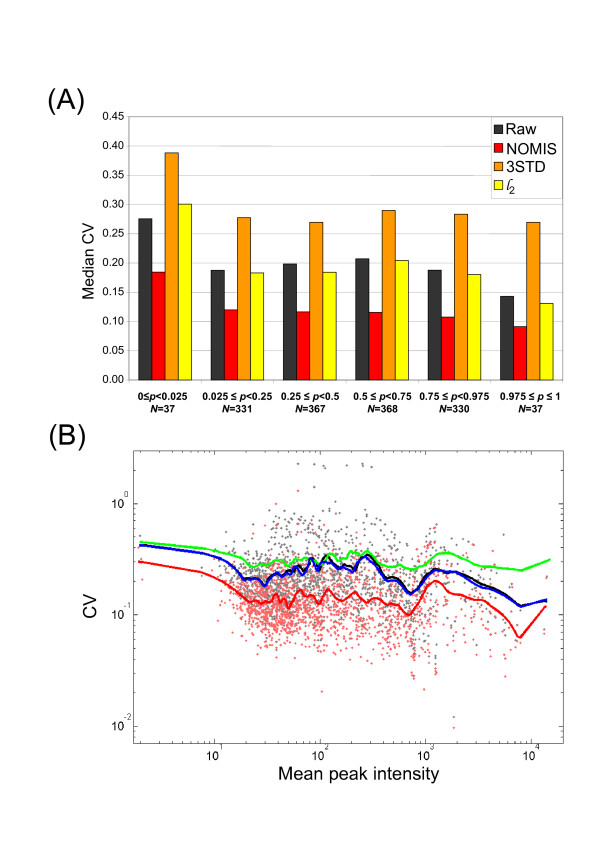
Effect of normalization methods on heteroscedasticity in the data. (A) The sorted mean intensity values for 1470 peaks are divided into six bins defined by the quantiles for the following cumulative probabilities: P= [0.025, 0.25, 0.5, 0.75, 0.975]. The first bin therefore contains the low abundance peaks on the left tail of the intensity distribution, with cumulative probability p < 0.025. The median coefficients of variance were calculated within each bin. (B) Scatter plot of unnormalized and NOMIS normalized peaks. The solid curves, shown for all four methods compared, are drawn as guides using robust locally weighted regression and smoothing scatter plots method (LOWESS) [22] with the 100 variable window size smoothing kernel.